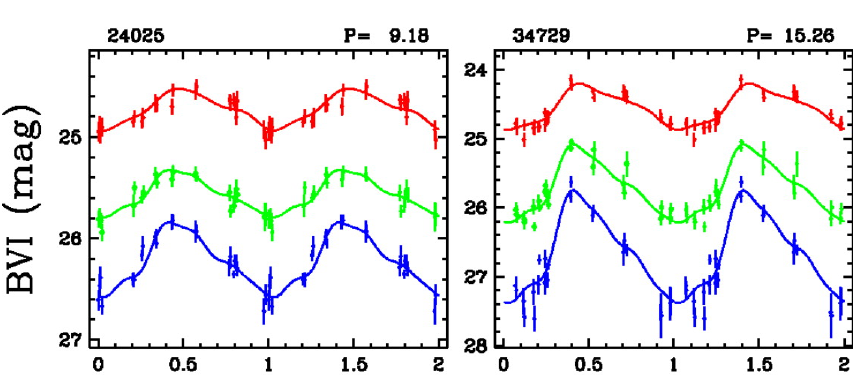
Figure 7: Positions of Cepheid variables in HST/ACS observations of the galaxy NGC 4258. Typical Cepheid lightcurves are shown on the top. Image reproduced with permission from [129]; copyright by